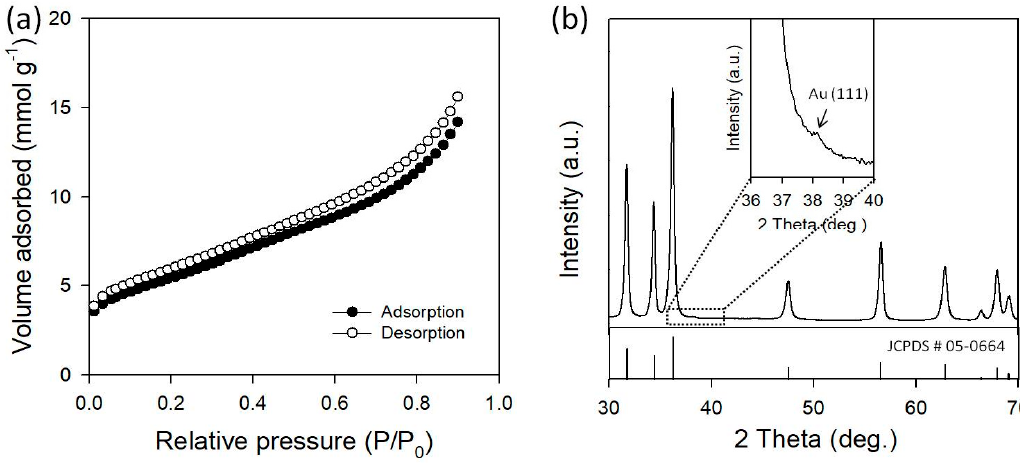
Figure 2. ( a ) Adsorption-desorption isotherm and ( b ) XRD pattern of Au/ZnO synthesized in a micro-reactor (Inset of magnified XRD pattern for Au (111) and JCPDS No. 05-0664 of hexagonal ZnO crystal).